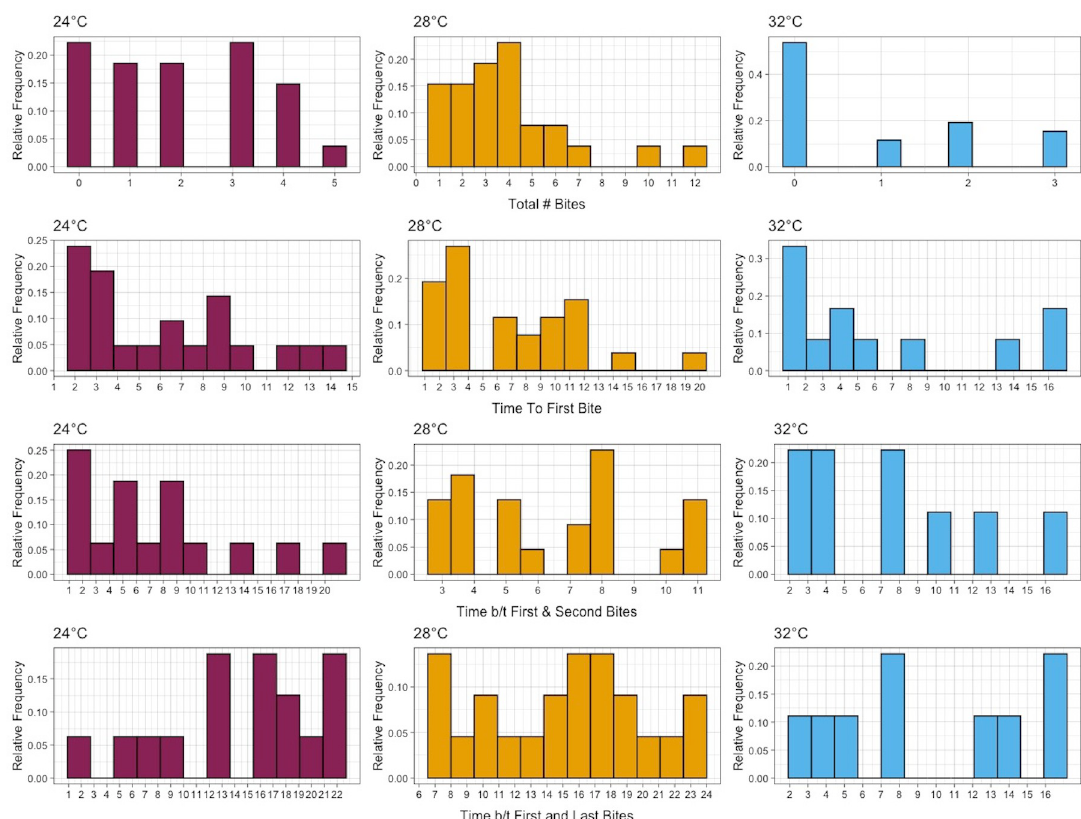
Fig 1. Summary of Ae. aegypti biting characteristics at three temperatures. Top Row: Total number of bites out of all mosquitoes. Second row: Time to first bite of all mosquitoes that bit at least once. Third Row: Time between the first and second bites of mosquitoes that bit at least twice. Bottom row: Time between first and last bites of mosquitoes that bit at least twice.